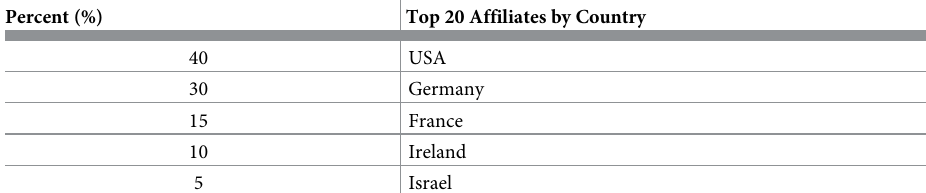
Table 1. Top 20 affiliates, country of origin.